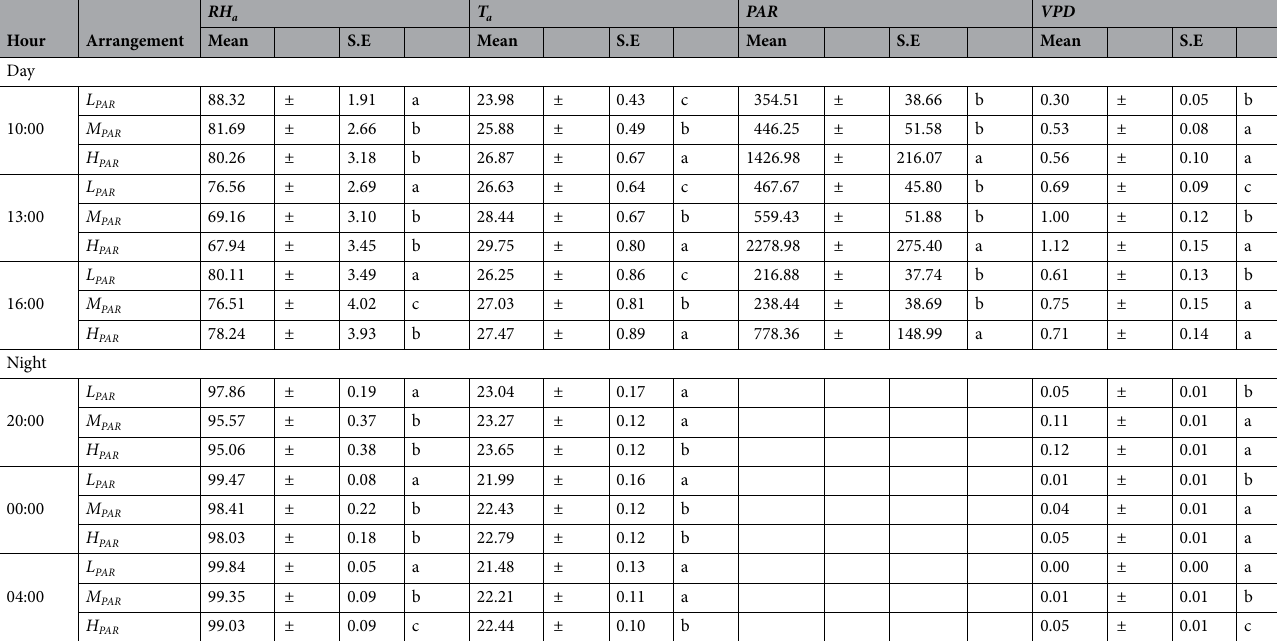
Table 2. Mean values ± SE of the microclimatic variables during the monitoring period under different radiation intensities and at different hours of the day (official hours UTC/GMT—5:00 h): air relative humidity ( RH a , %), air temperature ( T a , °C), photosynthetically active radiation ( PAR , µmol m −2 s −1 ), vapor pressure deficit ( VPD , kPa). The agroforestry arrangements are described in the methods section and Fig. 2. Values in a column that have different letters within the same time slot indicate significant differences between AFs (post- hoc LSD tests, p <